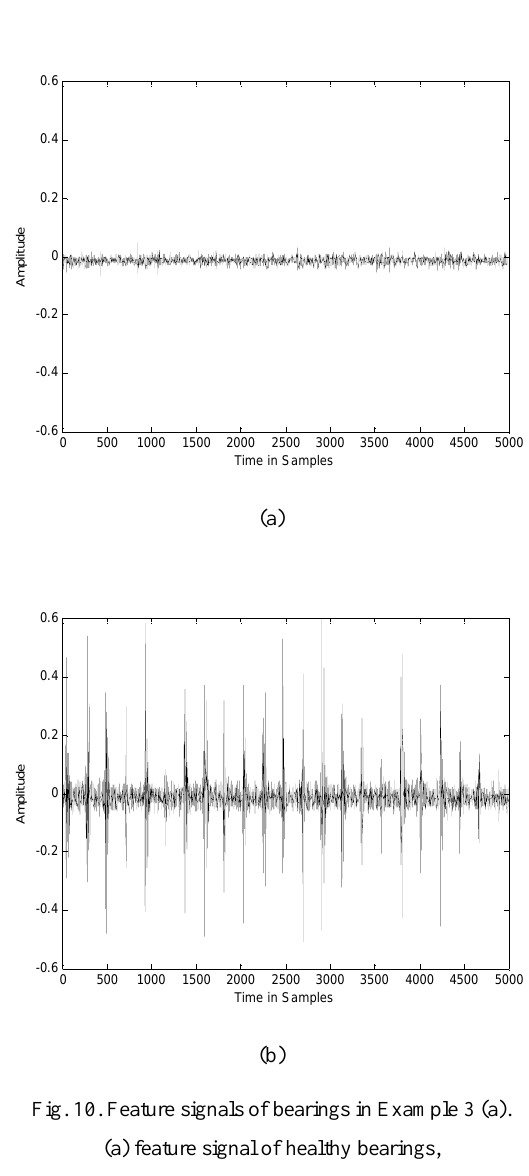
Fig. 10. Feature signals of bearings in Example 3 (a). (a) feature signal of healthy bearings, (b) feature signal of faulty bearings with ball damage